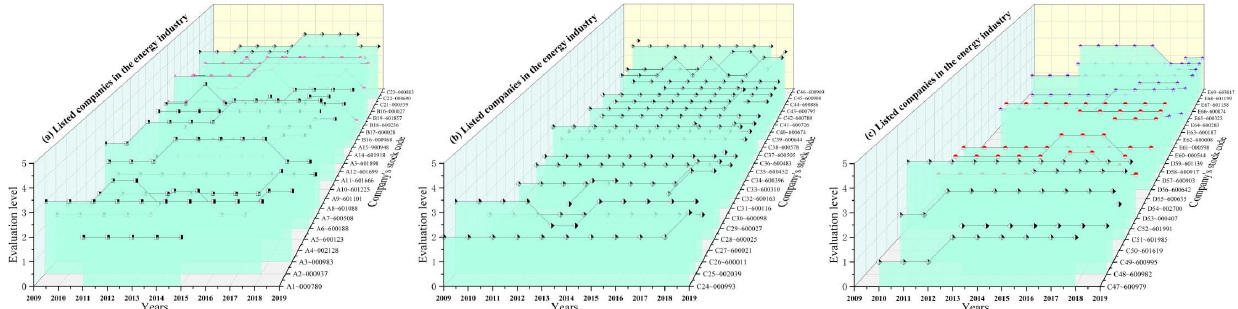
Figure 2. Comprehensive evaluation results of the OHSML of each company from 2009 to